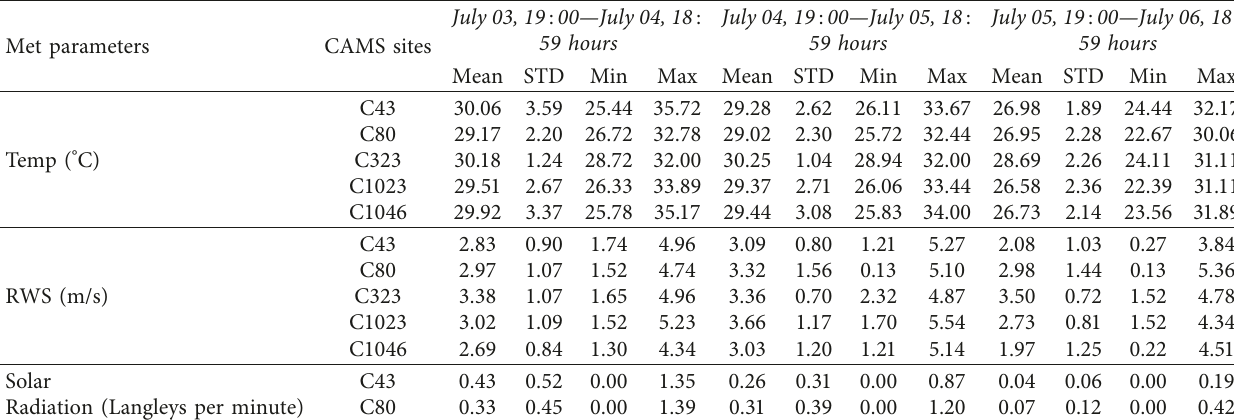
Table 2: Meteorological parameters during the study period at the various CAMS